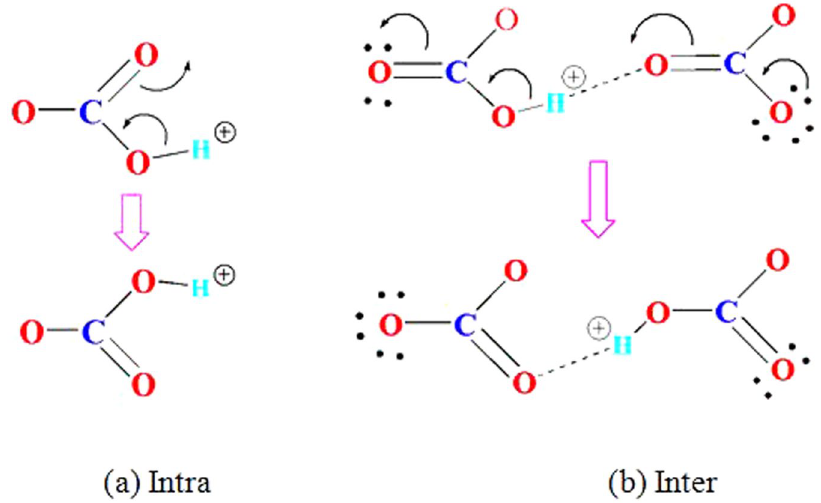
Figure 6. Lewis Diagram for the Intra- ( a ) and Inter-Carbonate ( b ) Migration of